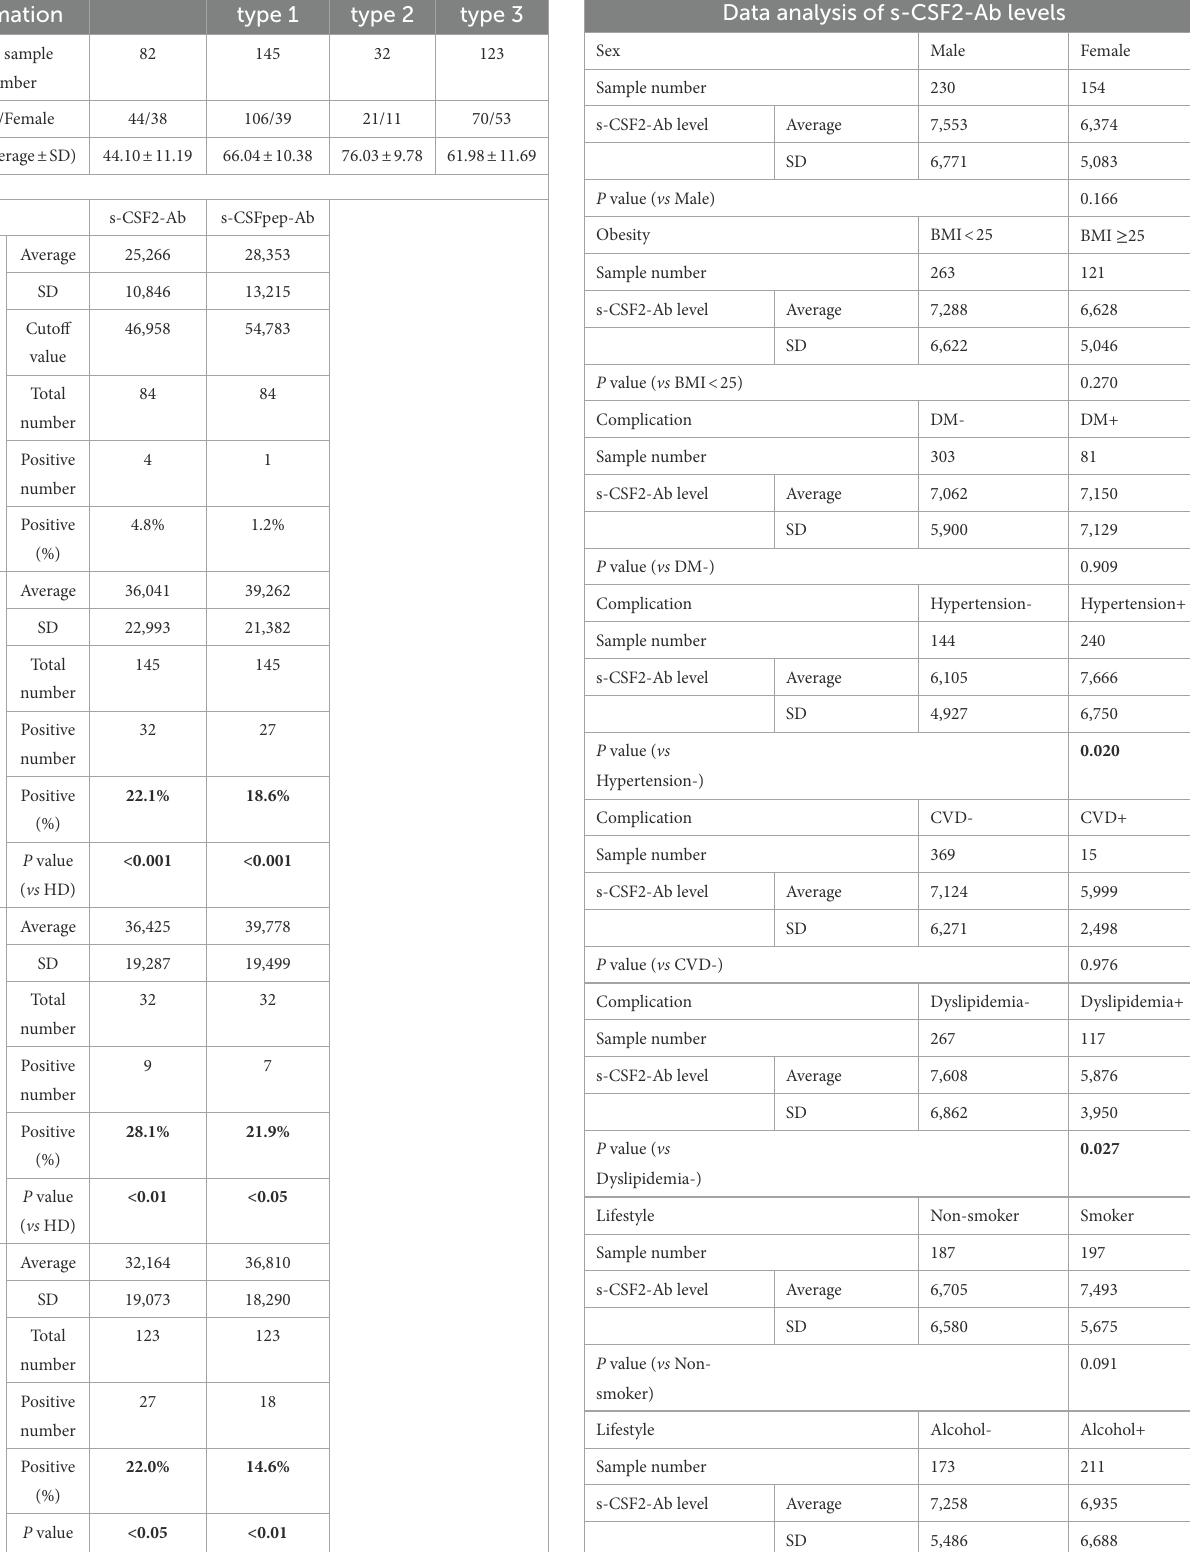
participants in the Sawara Hospital cohort. Data analysis of s-CSF2-Ab